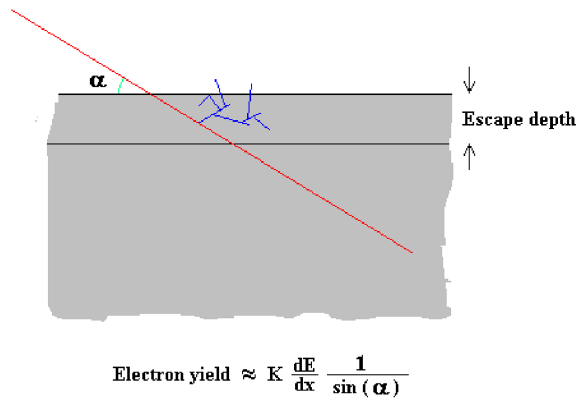
FIG. 1. (Color) Simple model for the angular and dE=dx